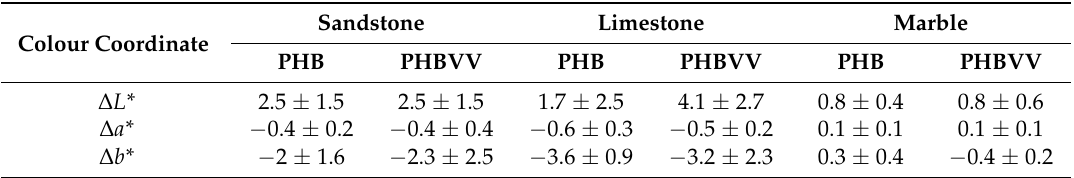
Table 8. Average Δ L* , Δ a* and Δ b* values of sandstone, limestone and marble treated with PHB and Table 8. Average ∆ L* , ∆ a* and ∆ b* values of sandstone, limestone and marble treated with PHB and PHBVV with respect to untreated conditions. PHBVV with respect to untreated conditions. Sandstone Limestone Colour Coordinate Sandstone Limestone Colour Coordinate